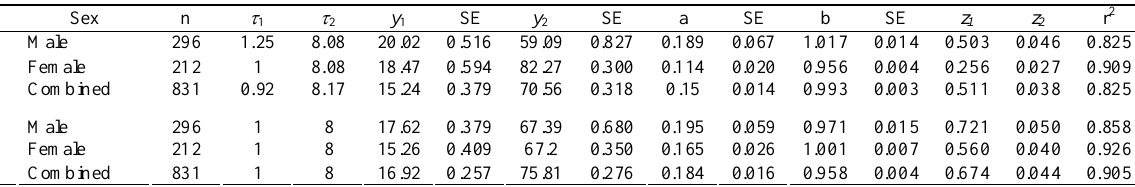
Table 2. Growth parameters calculated from observed lengths (OL) and back-calculated (BC) lengths, using Schnute model = first specified age; τ (1981). τ 1 relative rate of relative growth rate; y rate at age τ ( SE - standard error; r 2 - coefficient of determination). 2